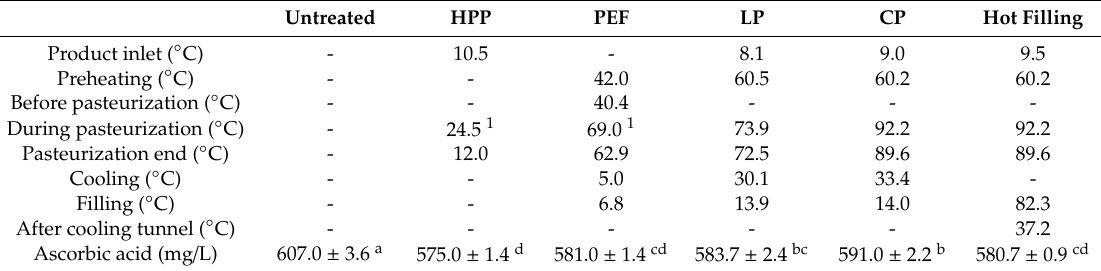
Table 1. Product temperatures during the di ff erent process steps applied to Valencia orange juice and ascorbic acid contents. Di ff erent letters indicate significant di ff erences ( p ≤ 0.05). Ascorbic acid concentrations are means ± standard deviation ( n = 3). HPP: high pressure processing; PEF: pulsed electric fields; LP: low pasteurization; CP: conventional pasteurization.